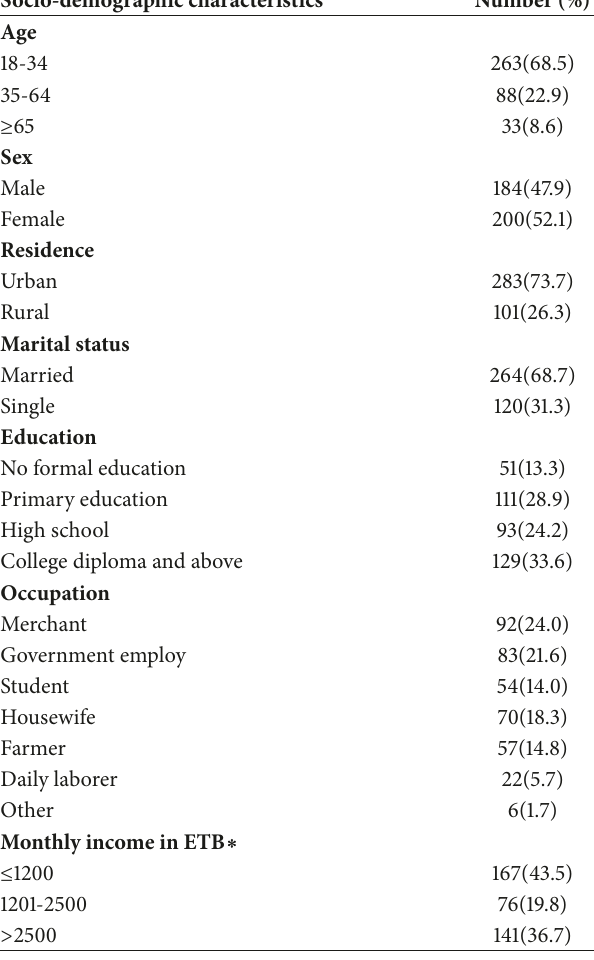
Table 1: Sociodemographic characteristics of participant in Harar city and its surrounding residents from February 1 to May 1, 2017